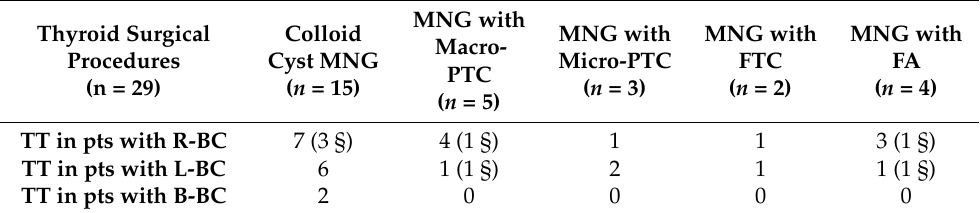
Table 2. Thyroid histological findings in the cohort of patients previously operated for BC who underwent thyroid